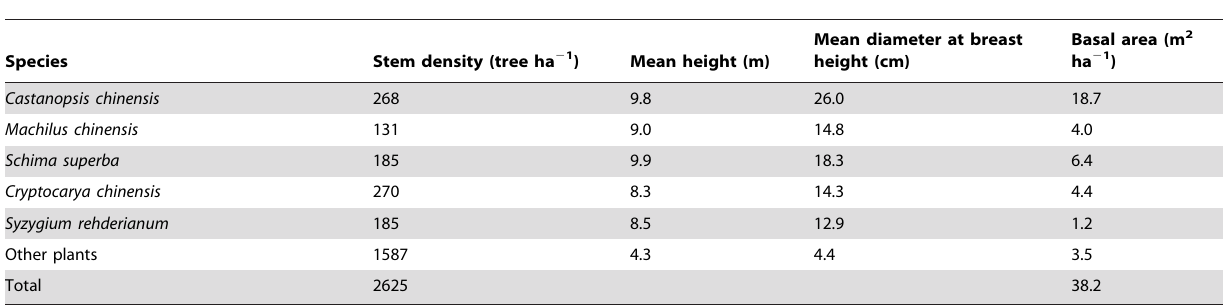
Table 1. Indices of the old-growth tropical forest at Dinghushan Biosphere Reserve.